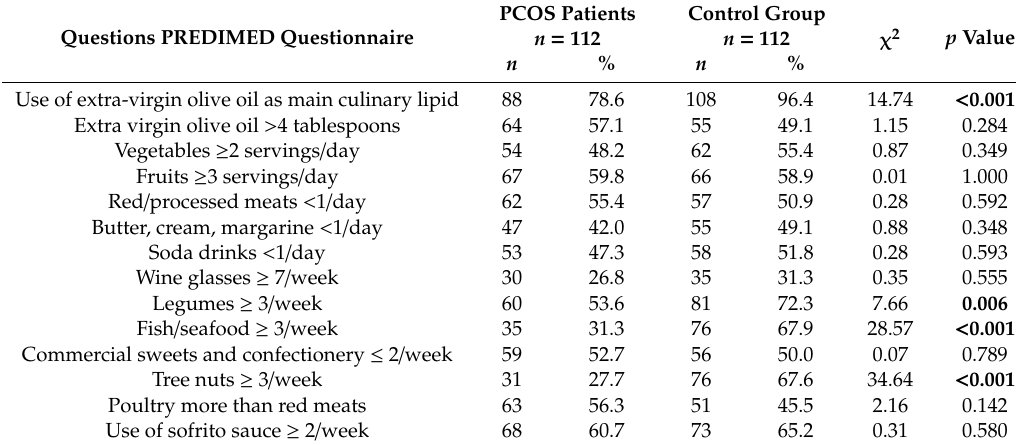
Table 2. Response frequency of dietary components included in the PREvenci ó n con DIetaMEDiterr á nea (PREDIMED) questionnaire of the polycystic ovary syndrome (PCOS) patients and control group.